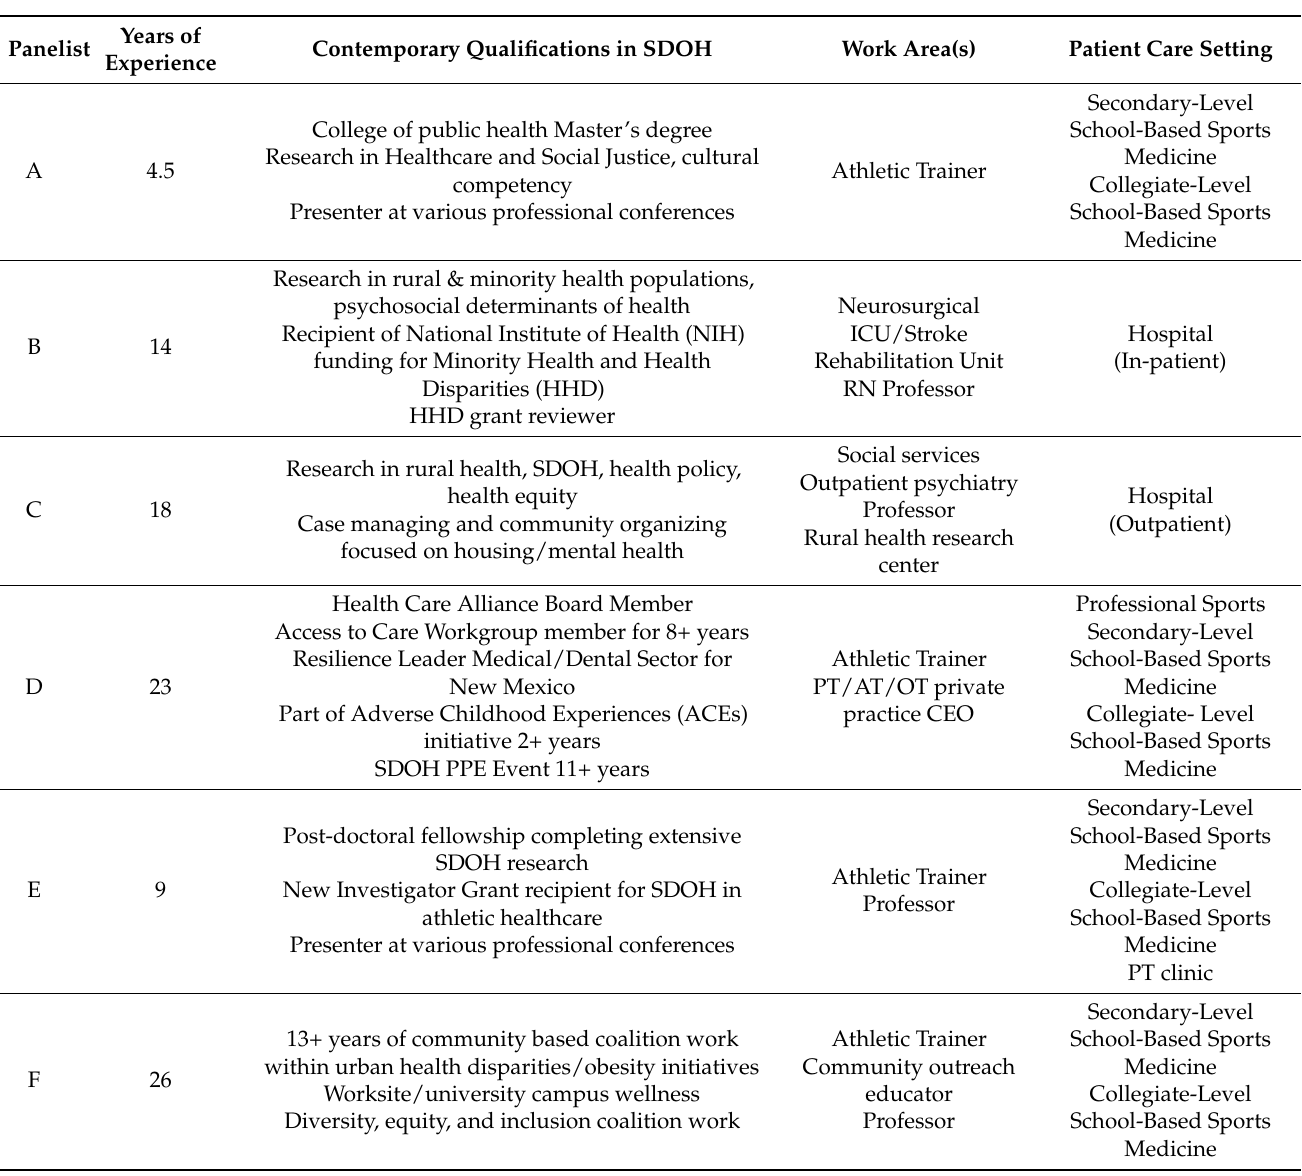
Table 1. Panelist